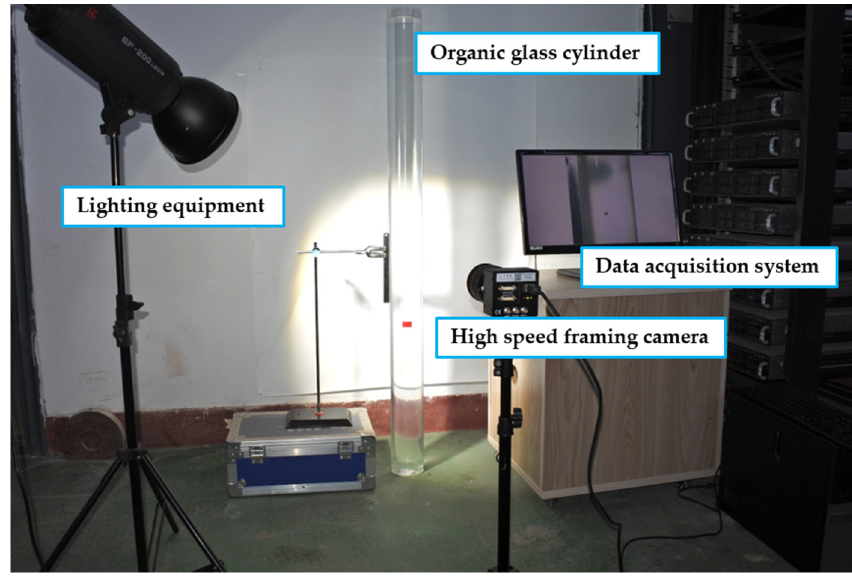
Figure 5. Schematic diagram of particle settlement experimental device.